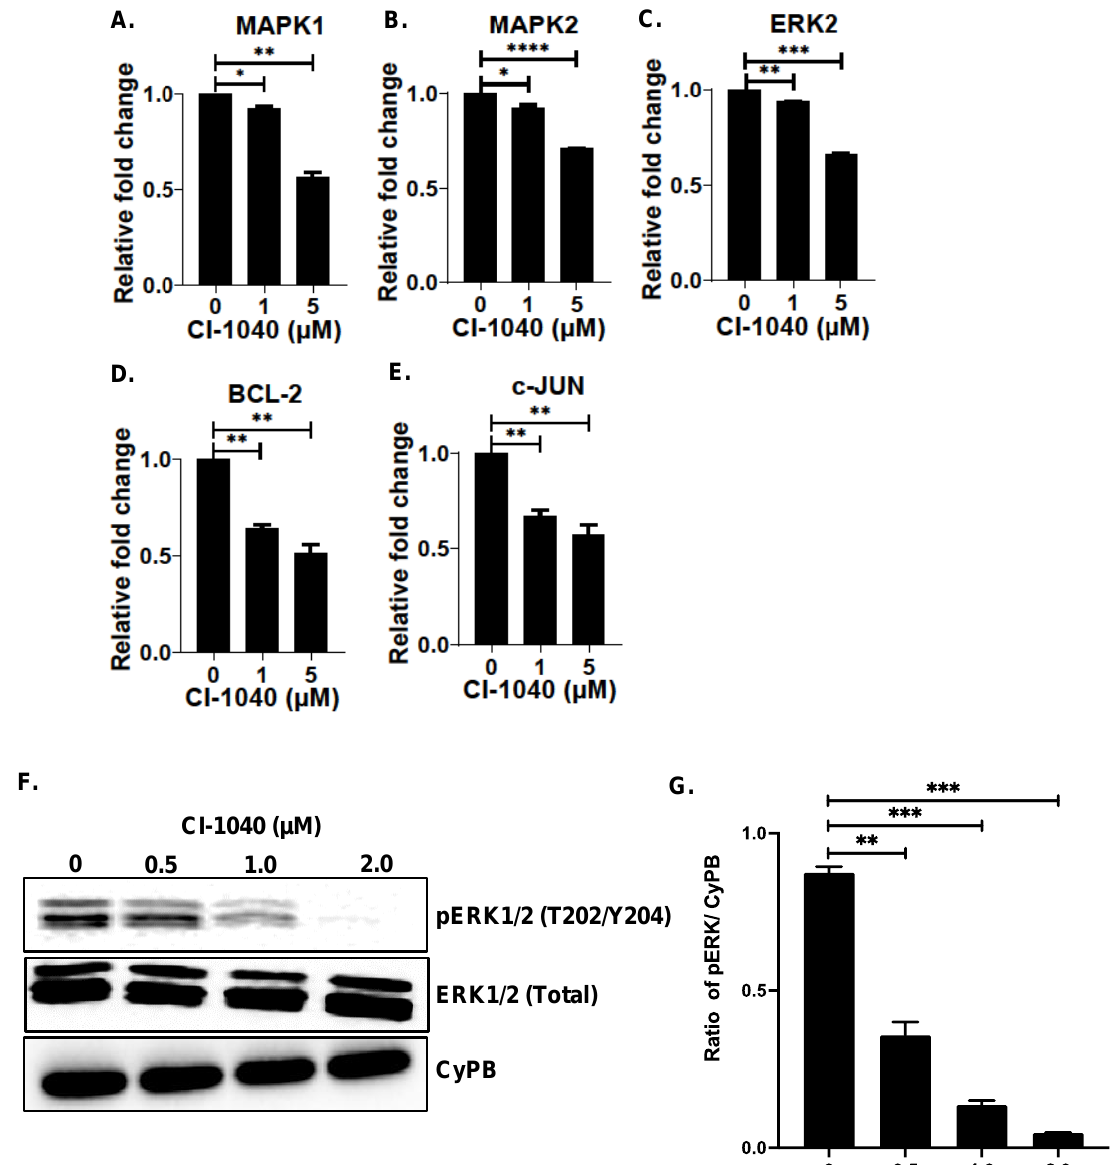
Figure 7. CI-1040 inhibits MEK/ERK pathway genes. ( A – E ) Gene expression analysis of different MAPK pathway and apoptosis related genes in response to CI-1040 treatment in SH-SY5Y cells. ( A ) MAPK1. ( B ) MAPK2. ( C ) ERK2. ( D ) BCL-2. ( E ) c-JUN . ( F , G ) Western blot analysis of total ERK1/2 and pERK1/2 (Thr202/Tyr204) in response to CI-1040 treatment. ( F ) Representative western blot images. ( G ) Densitometric analysis of pERK1/2 protein band as shown in F. * p < 0.05, ** p < 0.01, *** p < 0.001, and **** p <